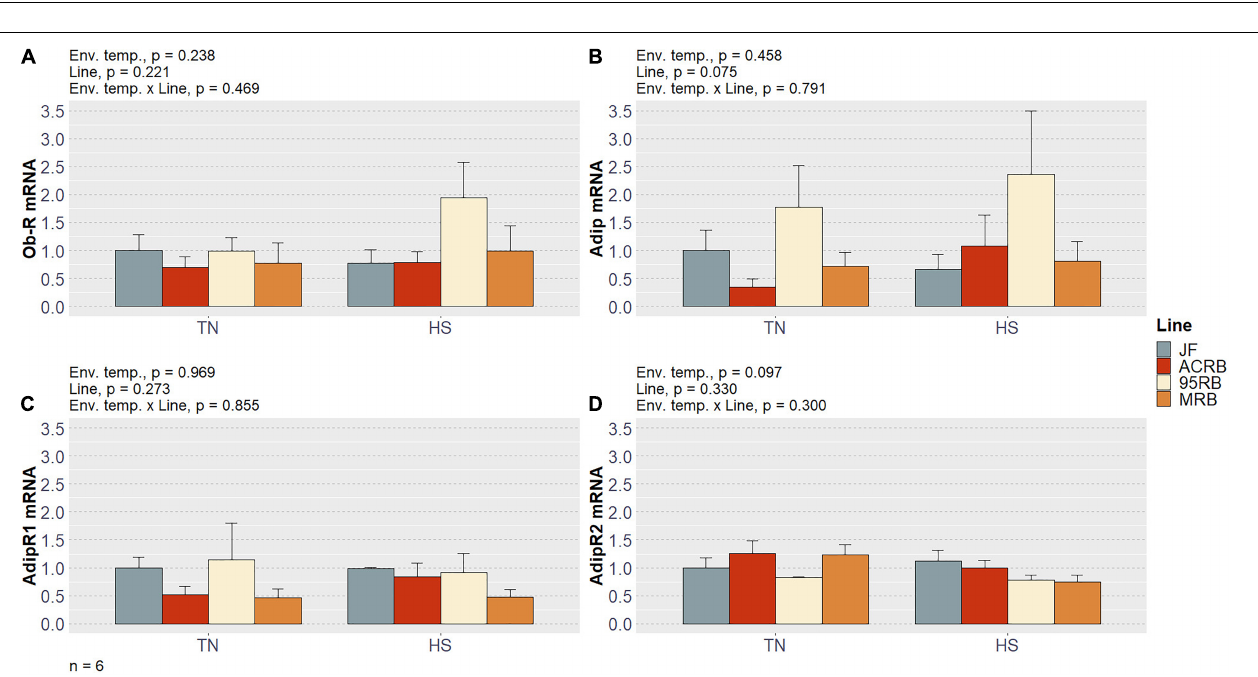
FIGURE 4 | Effect of cyclic heat stress on the hypothalamic expression of ghrelin (A) and its receptor (B) in JF and modern broilers. The mRNA abundances were determined by qPCR using 2 − (cid:49)(cid:49) Ct method. JF-TN group was used as a calibrator. Data are mean ± SEM ( n = 6 birds/group). HS, heat stress; TN, thermoneutral.